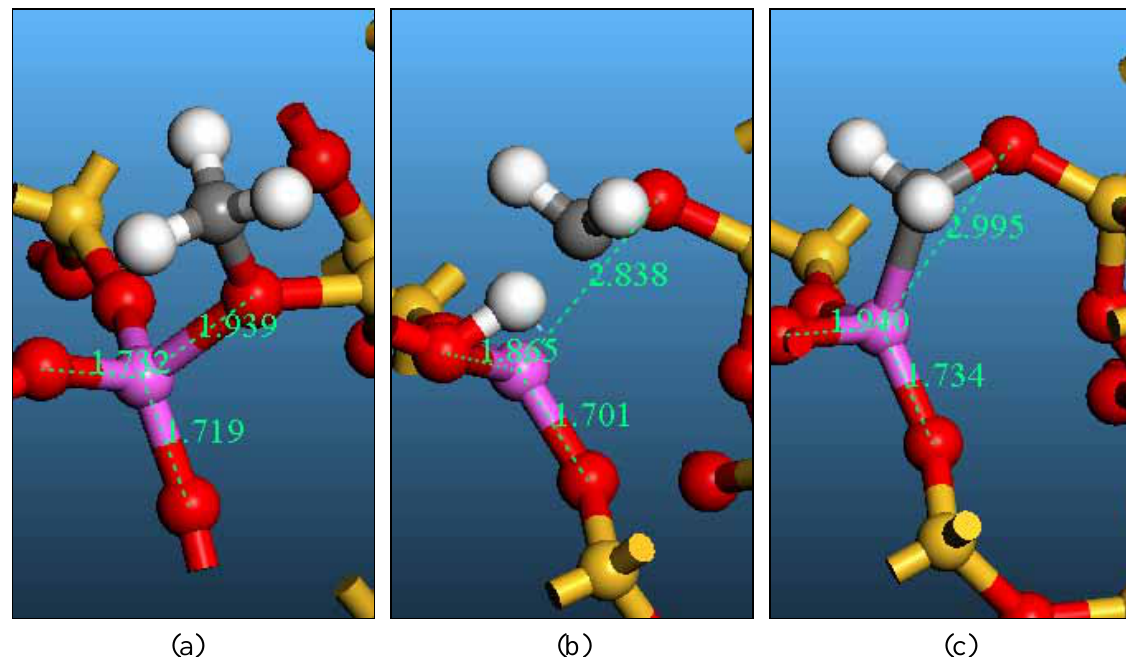
Figure 7. Local distortion around the Brønsted acid site. (a) Surface methoxyl, (b) Transition state structure, (c) ylide structure incorporated into the zeolite